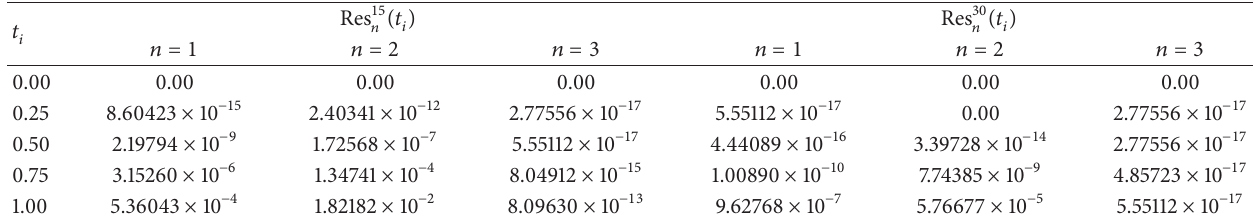
Table 4: The values of residual error functions Res 𝑘 𝑖 (𝑡) , 𝑖 = 1 , 2, 3, to Example 2 when 𝑘 = 15 ,